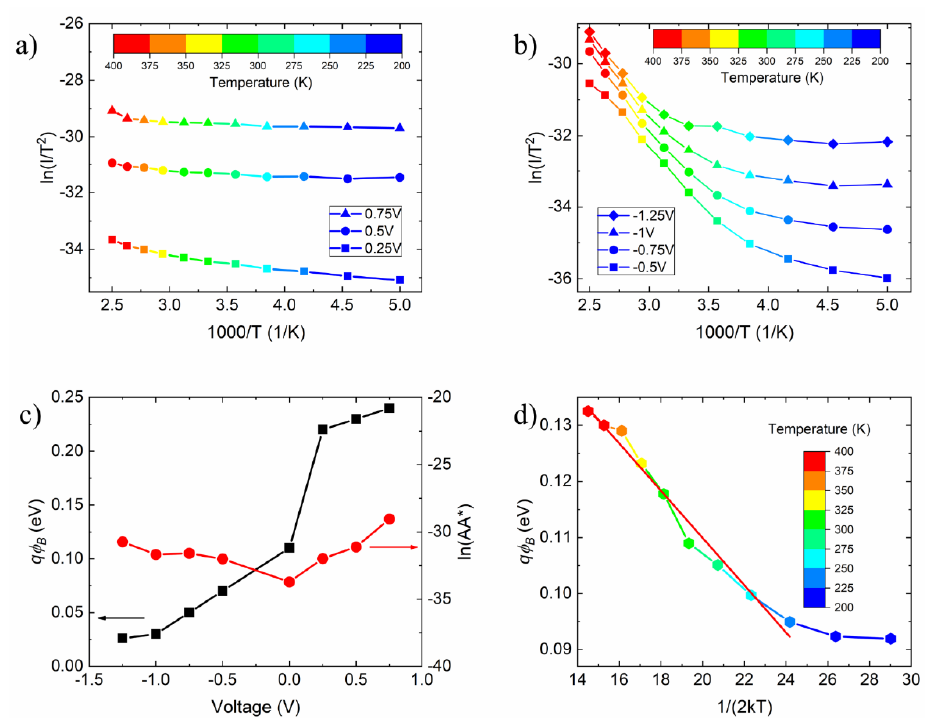
Figure 4. ( a ) Richardson plot of ln(𝐼/𝑇 2 ) vs 10 3 𝑇 in forward and ( b ) in reverse bias. ( c ) Schottky barrier and ln(𝐴𝐴 ∗ ) respect the bias. ( d ) Schottky barrier height at zero bias as a function of temperature.